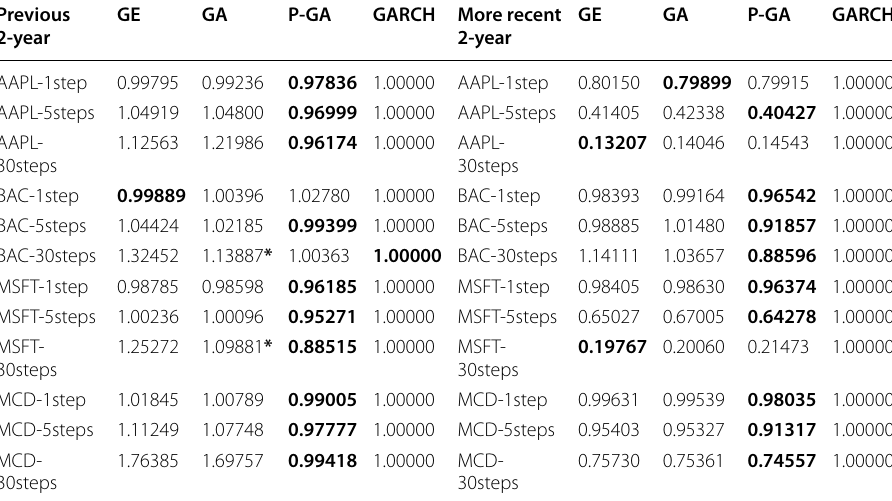
Column names “GA” and “GE” represent GE-NoVaS and GA-NoVaS methods, respectively; “GARCH” means the GARCH-direct method; and “P-GA” means the P-GA-NoVaS method. The benchmark is the GARCH-direct method, so numerical values in the table corresponding to the GARCH-direct method are 1. Other numerical values are relative performance compared to the GARCH-direct method. The bold value indicates that the corresponding method is the optimal choice for this data case. A cell with indicates that the GA-NoVaS method is at least 10 % better than the GE-NoVaS method, or inversely, the ∗ GE-NoVaS method is at least 10 %